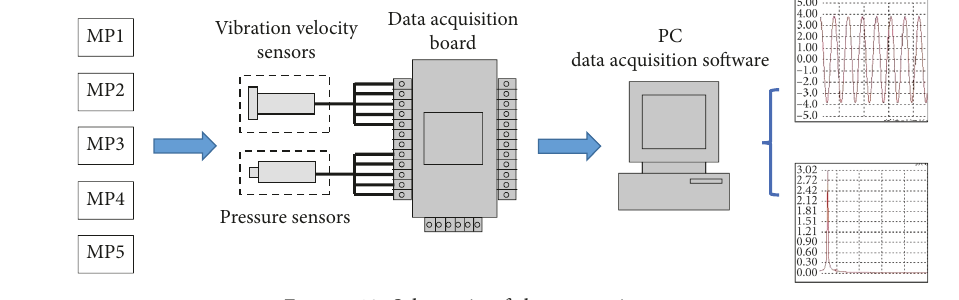
Figure 13: Schematic of the measuring system.